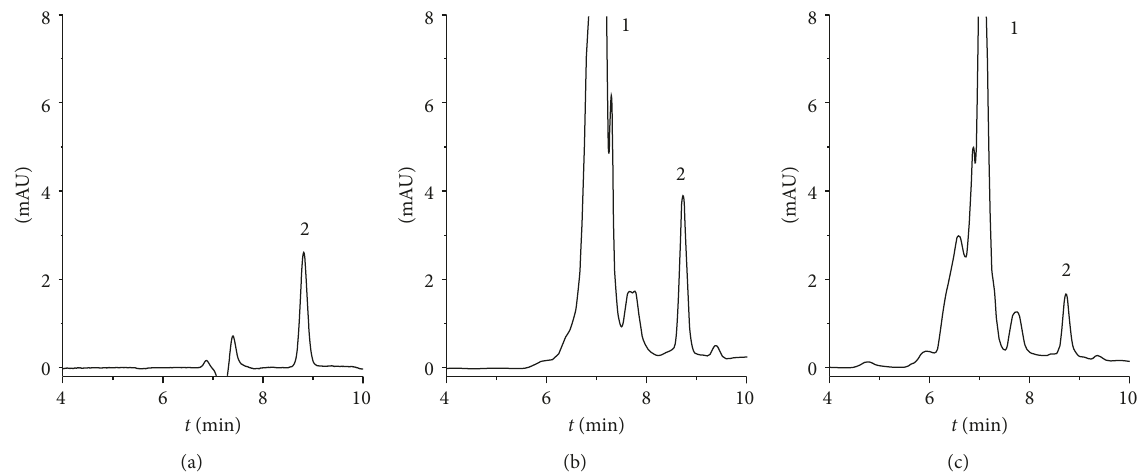
Figure 7: The results of ultrafiltration-LC experiment: (a) compound DBDF2,6Tdissolved in 50% aqueous methanol; (b) the sample which was prepared using natural protein; (c) the negative control which was prepared using denatured protein. 1: the peak of impurities from solvent of protein hPPAR; 2: the peak of compound